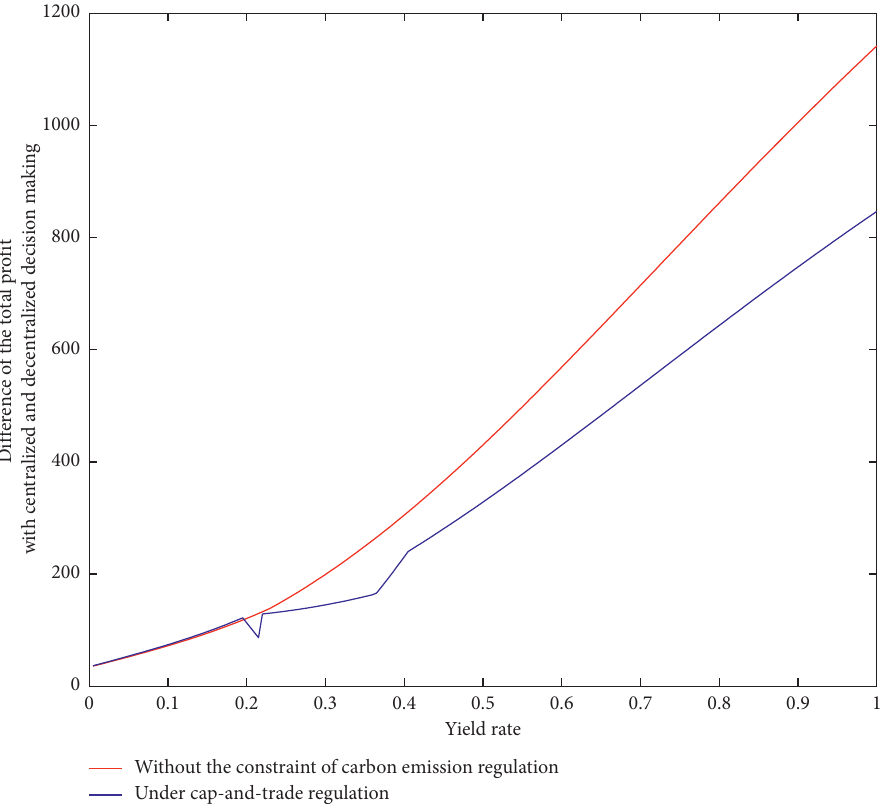
Figure 7: Difference in total profit with centralized and decentralized decision making vs. yield